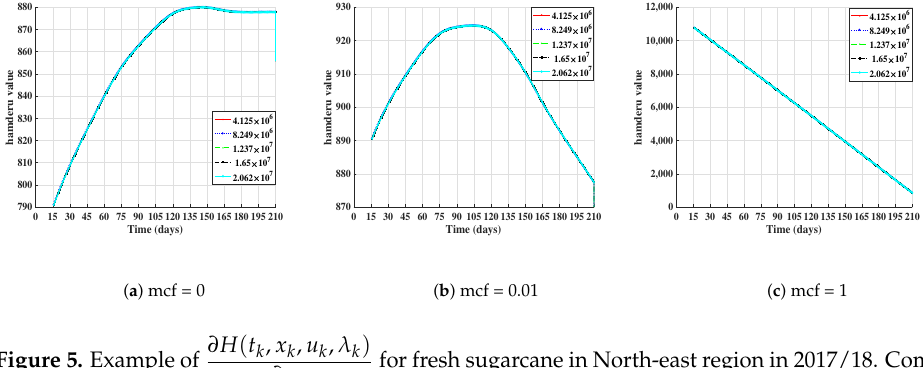
∂ H ( t k , x k , u k , λ k ) Figure 5. Example of for fresh sugarcane in North-east region in 2017/18. Compare ∂ u k optimal cutting plots in Figure